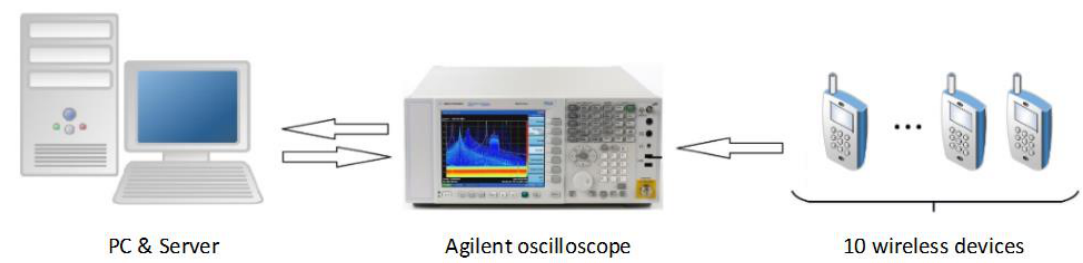
Figure 2. The experimental